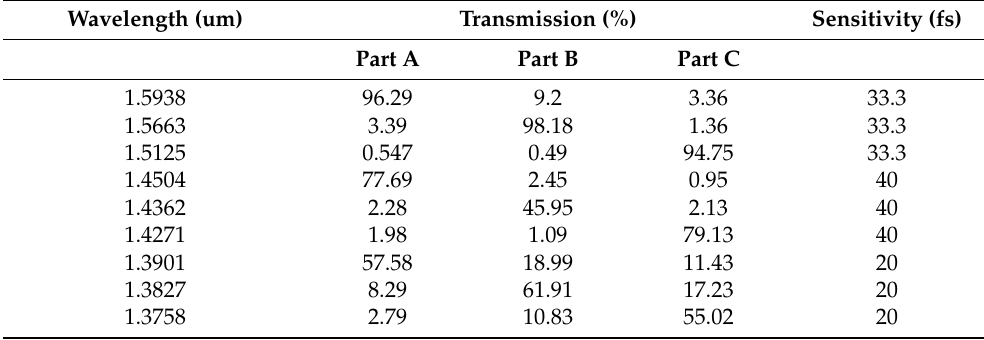
Table 1. Download efficiency, crosstalk, and sensitivity of each channel of the filter for different wavelengths.